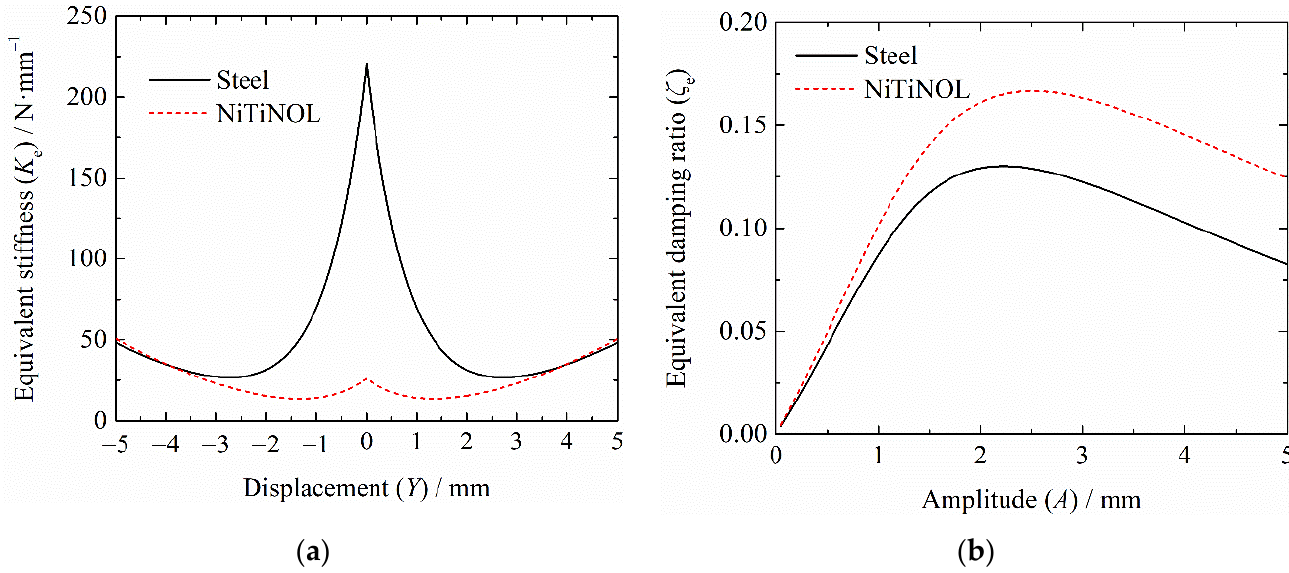
Figure 3. The characteristic indicators of the isolators with a steel wire rope and a NiTiNOL wire rope. ( a ) The generalized equivalent stiffness and ( b ) the generalized equivalent damping ratio.